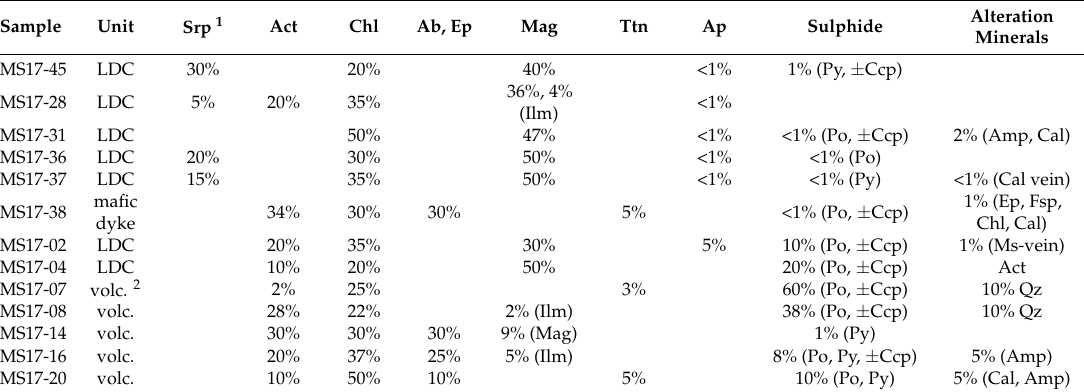
Table 4. Approximate proportions (vol %) of minerals observed in thin